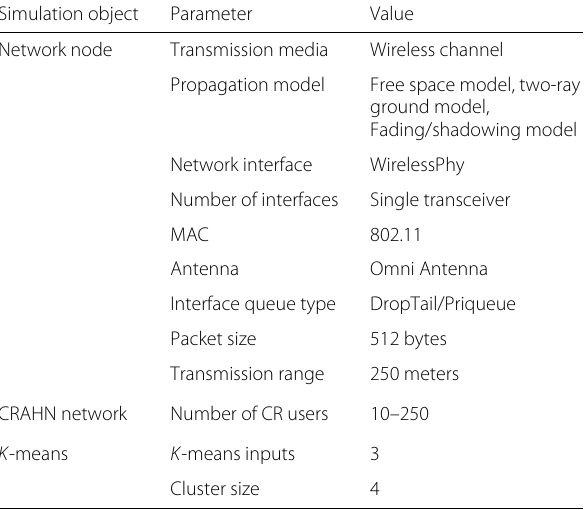
Table 4 The simulation parameters